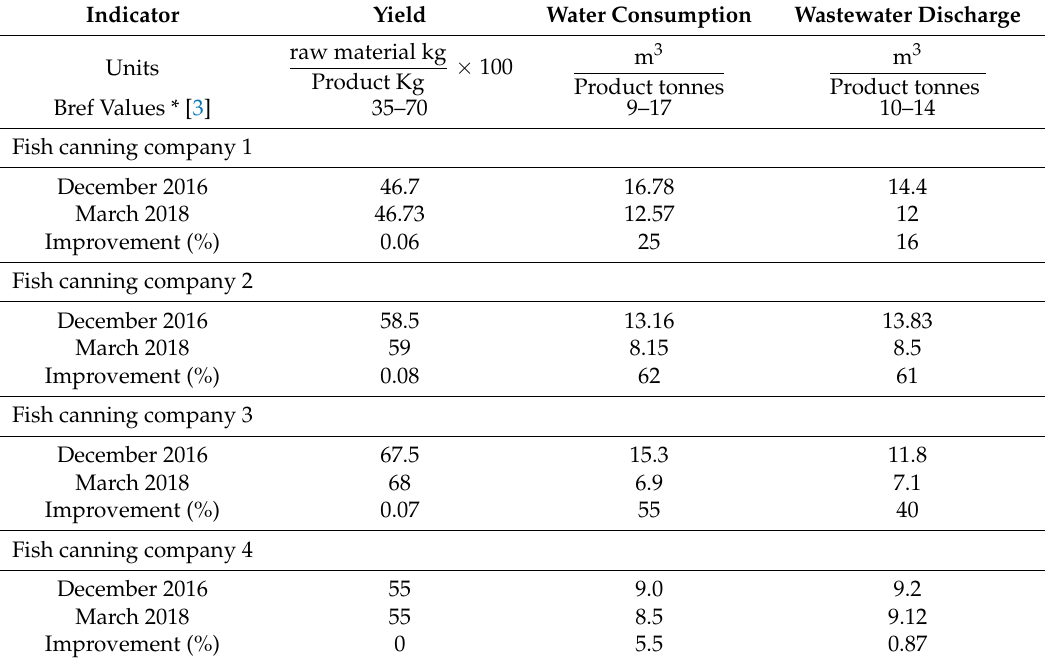
Table 6. Production indicators after implementing improvement